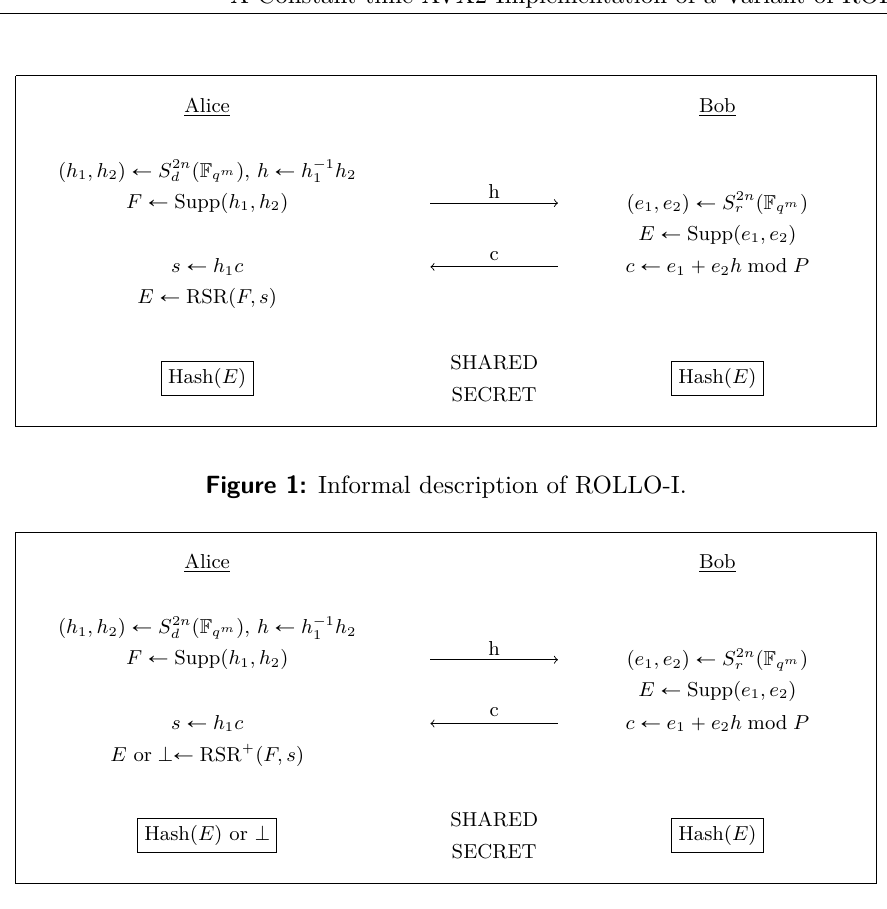
Figure 2: Informal description of ROLLO `